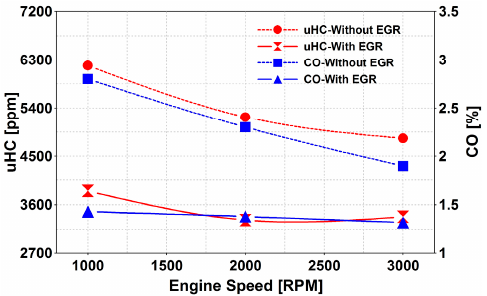
Figure 14. Influence of In/Ex-EGR on uHC and CO concentrations at idling and low/mid-load settings (rpm = 1000-3000, IMEP = 1-2.1 bar, T epc = 385-530 K, AFR = 14–16).